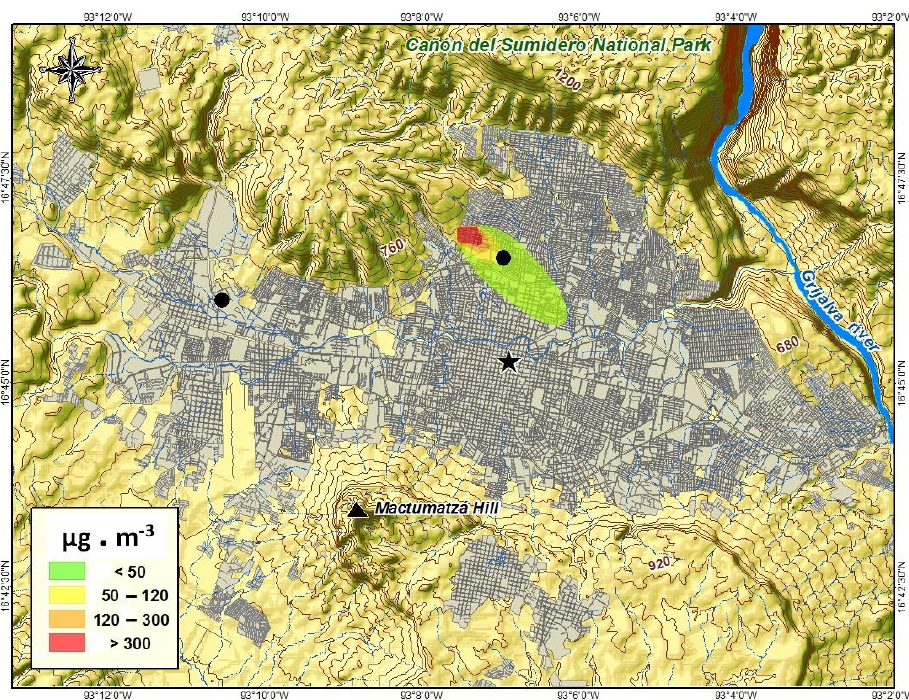
Figure 6. Dispersion of PM 10 dust particles over TGZ as simulated by the ISC3 model. Plume Figure 1. Sites selected in Tuxtla Gutiérrez (TGZ) to quantify emissions from unpaved roads are originating from Lajas Maciel during February 27th, 2014. Points for Minivol monitoring PM 10 represented by red polygons and refer to Lajas Maciel (LM) and Plan de Ayala (PA). A and B represents points for monitoring PM 10 concentration. The central part of the city is represented by . The concentration are represented by . The central part of the city is represented by blue lines represent the presence of rivers and streams. The brown slight lines represent elevation in meters above sea level.